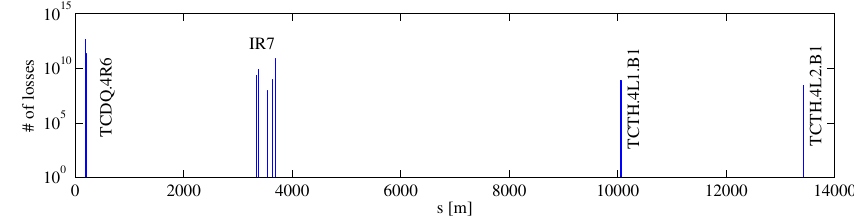
FIG. 14. (Color) Losses around the LHC for the 7 TeV prefire case, average over ten different orbit